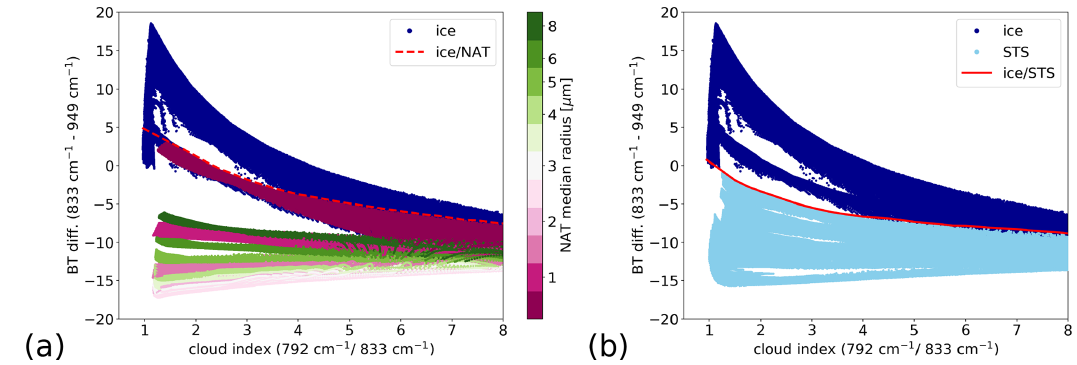
Figure 6. Correlation between the BT difference (832–834cm − 1 ) – (947.5–950.5cm − 1 ) and the cloud index. The red solid line shows the separation line between ice and STS, and the dashed line marks the separation between ice and NAT.